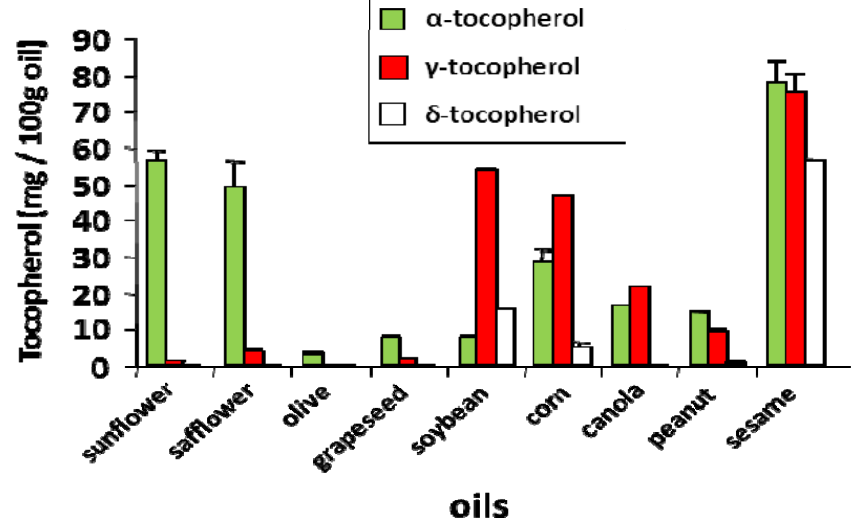
Figure 2. α -Tocopherol and γ -tocopherol in dietary oils. Adapted from [5]. Tocopherols from dietary oils (sunflower oil from Spectrum Organic Products, LLC; safflower oil from Spectrum; olive oil from Colavita; soybean oil from Crisco; corn oil from Mazola; grapeseed oil from Kusha, Inc.; peanut oil from Essentials by Supervalu; canola oil from Crisco; sesame oil from Lavita). Tocopherols were extracted from dietary oils and measured by HPLC with an electrochemical detector as previously described